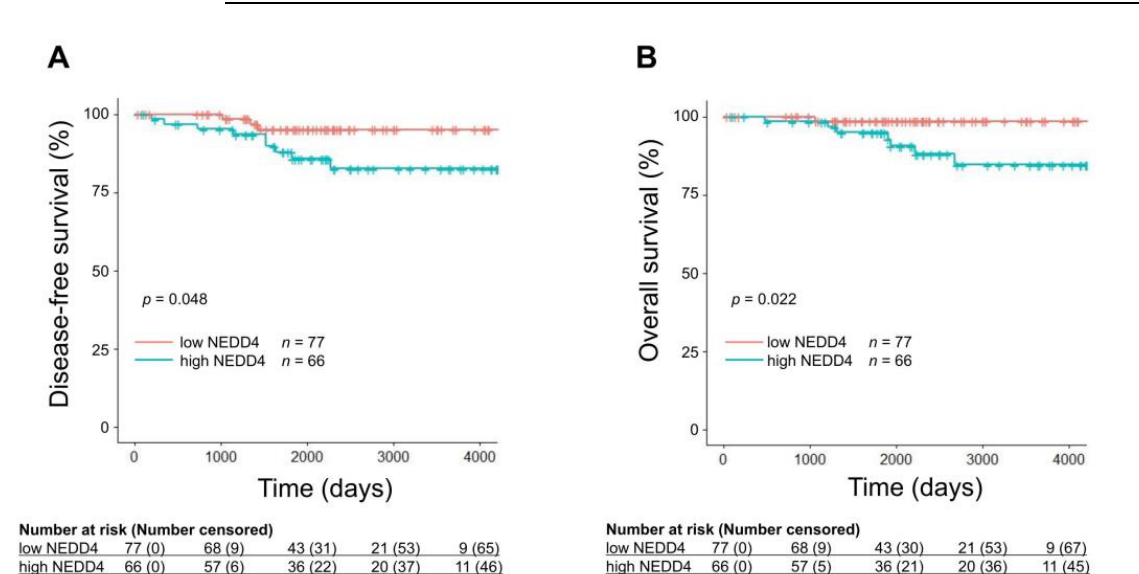
Figure 2. Prognostic impact of NEDD4 on HR-positive HER2-negative breast cancer patients. ( A ) Kaplan–Meier curves for DFS showing a good outcome in the low NEDD4 group ( p = 0.048). ( B ) Kaplan–Meier curves for OS showing a good outcome in the low NEDD4 group ( p = 0.022). Log rank (Mantel–Cox) p -values < 0.05 were considered statistically significant. Table 2. Univariate log-rank analyses for prognostic factors and the NEDD4 mRNA level of HR- positive HER2-negative breast cancer; p -values that are statistically significant ( p < 0.05) are marked with an asterisk (*).